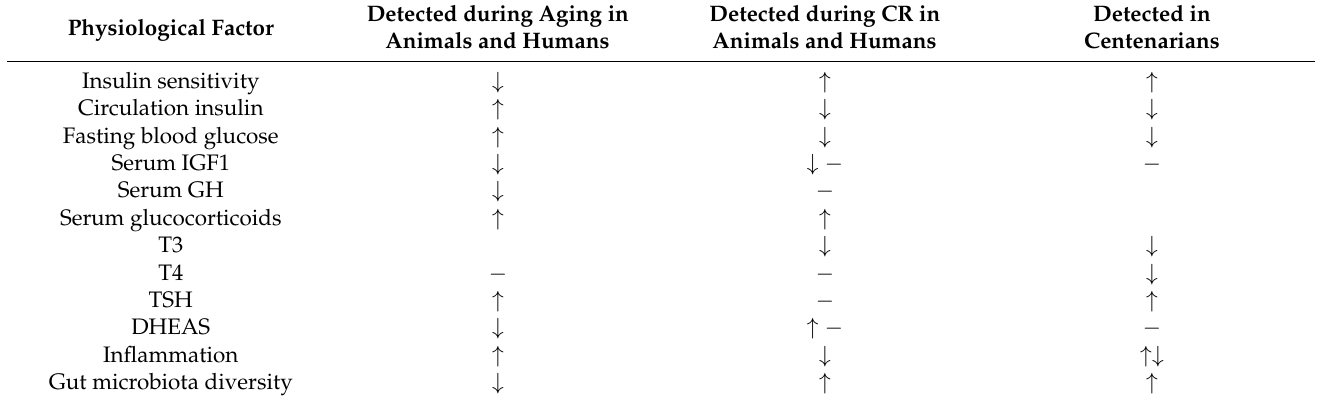
Table 2. The changes in various physiological factors detected in animals and humans during ag- ing and under CR. ↓ decrease; ↑ increase; − without change; IGF1—insulin-like growth factor 1; GH—growth hormone; T3—triiodothyronine; T4—thyroxine; TSH—thyroid-stimulating hormone; DHEAS—dehydroepiandrosterone sulfate. Detected during Aging in Detected during CR in Detected in Physiological Factor Animals and Humans Animals and Humans Centenarians Insulin